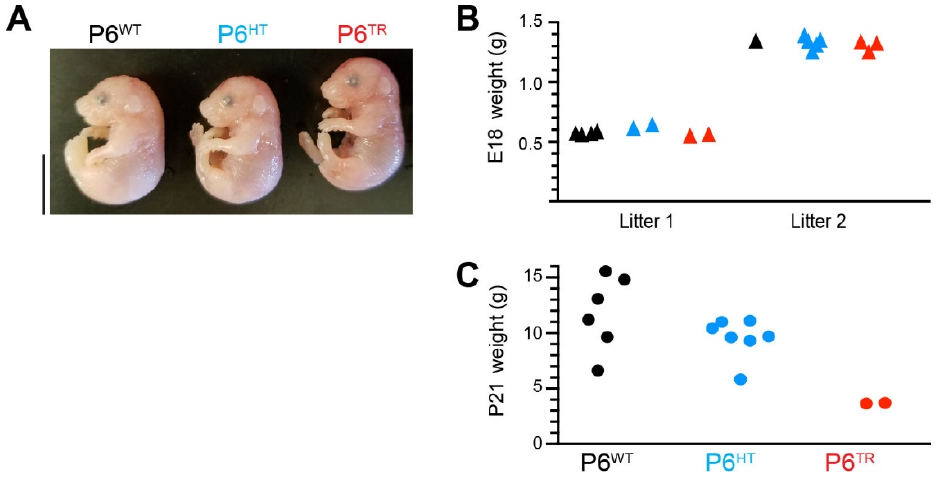
Figure 3. While Parp6 TR E18 embryos are indistinguishable from Parp6 WT and Parp6 HT embryos, P21 Parp6 TR mice are significantly smaller compared to Parp6 WT and Parp6 HT animals. ( A ) Representative image of Parp6 WT , Parp6 HT , and Parp6 TR embryos age E18, showing that they are indistinguishable from each other at this age. Scale bar: 1 cm. ( B ) Body weights of E18 embryos from two separate litters showing no significant differences (one-way ANOVA Litter 1 p = 0.4087 (n = 8), Litter 2 p = 0.1027 (n = 9). Combined, Parp6 TR and Parp6 HT are 97% and 104% of Parp6 WT , respectively. ( C ) Body weights of P21 animals (one-way ANOVA p = 0.0066; Parp6 TR and Parp6 HT are 31% ( p < 0.001) and 80% ( p < 0.05) from Parp6 WT , respectively).